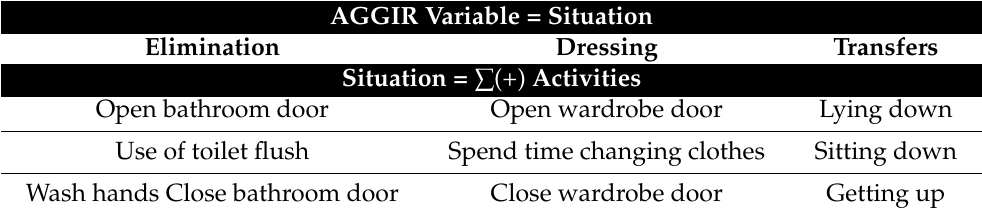
Table 11. Orchestration of the AGGIR variables.